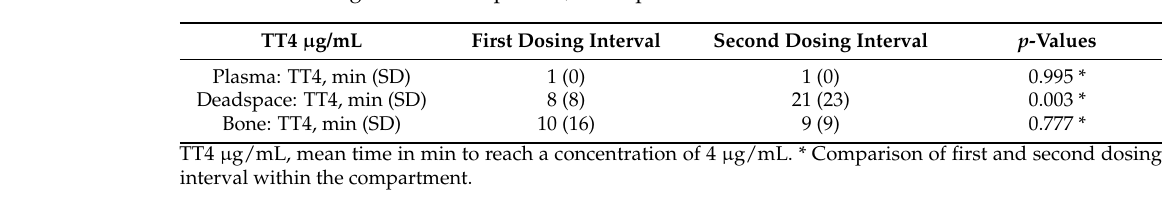
Table 4. A pooled comparison across weight groups of key pharmacokinetic parameters for the two dosing intervals in plasma, deadspace and